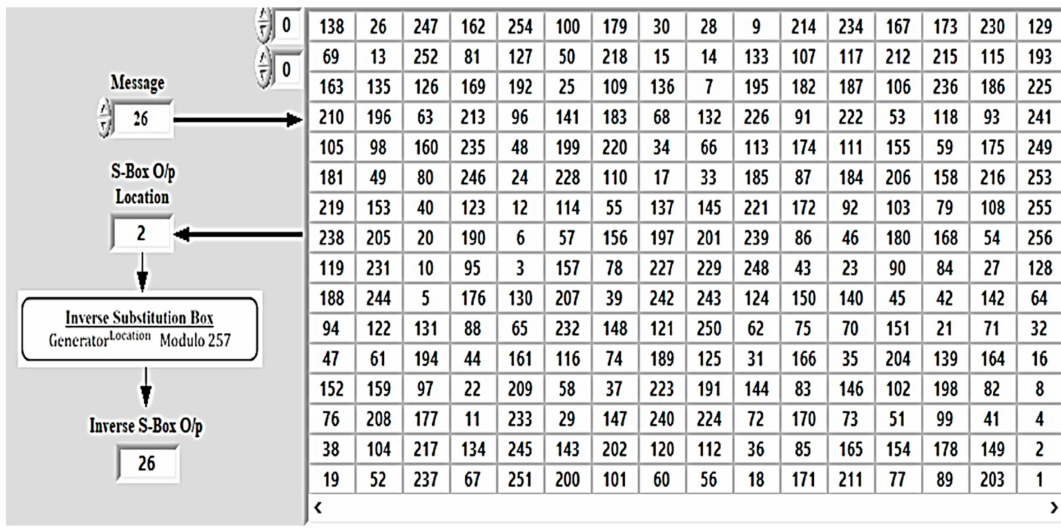
Figure 6. Substitution-box (S-Box) construction using